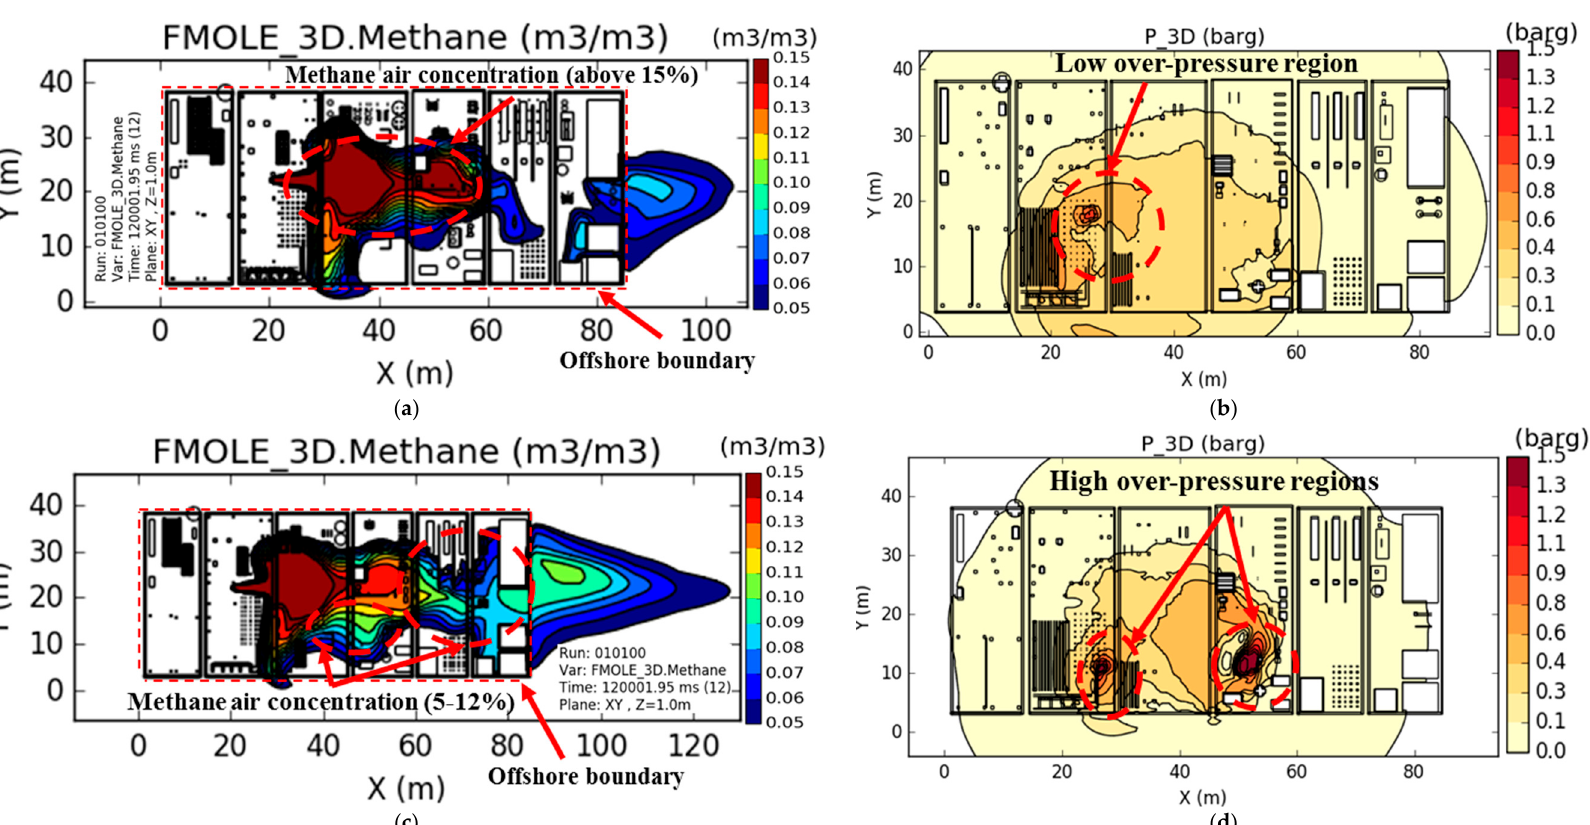
Figure 11. Methane–air concentration and VCE overpressure contours at 31 kg/s leak rate and RX+ leak direction. ( a ) Concentration profile of methane–air mixture at wind speed of 3 m/s. ( b ) Overpressure contour at wind speed of 3 m/s. ( c ) Concentration profile of methane–air mixture at wind speed of 7 m/s. ( d ) Overpressure contour at wind speed of 7 m/s.